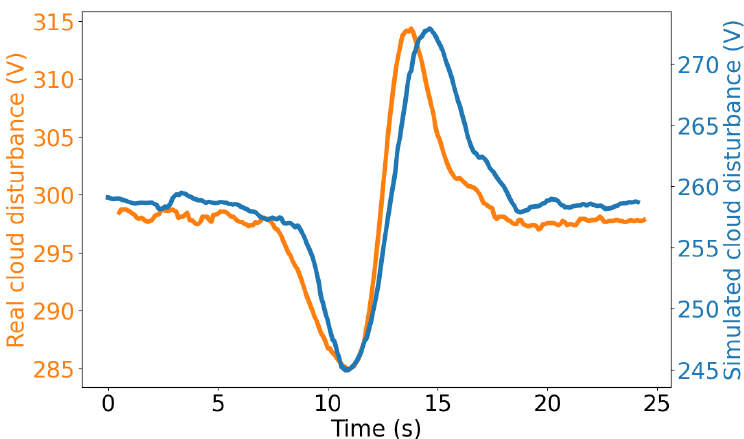
Figure 13. System voltage disturbance with real and simulated Cloud